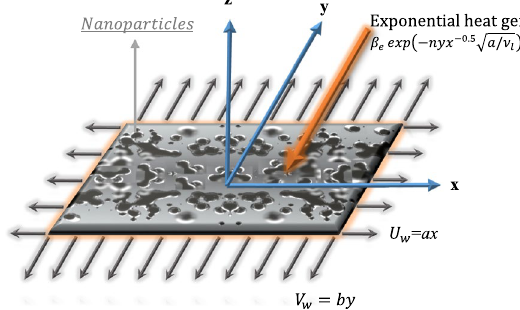
Figure 1. Schematic diagram of the considered